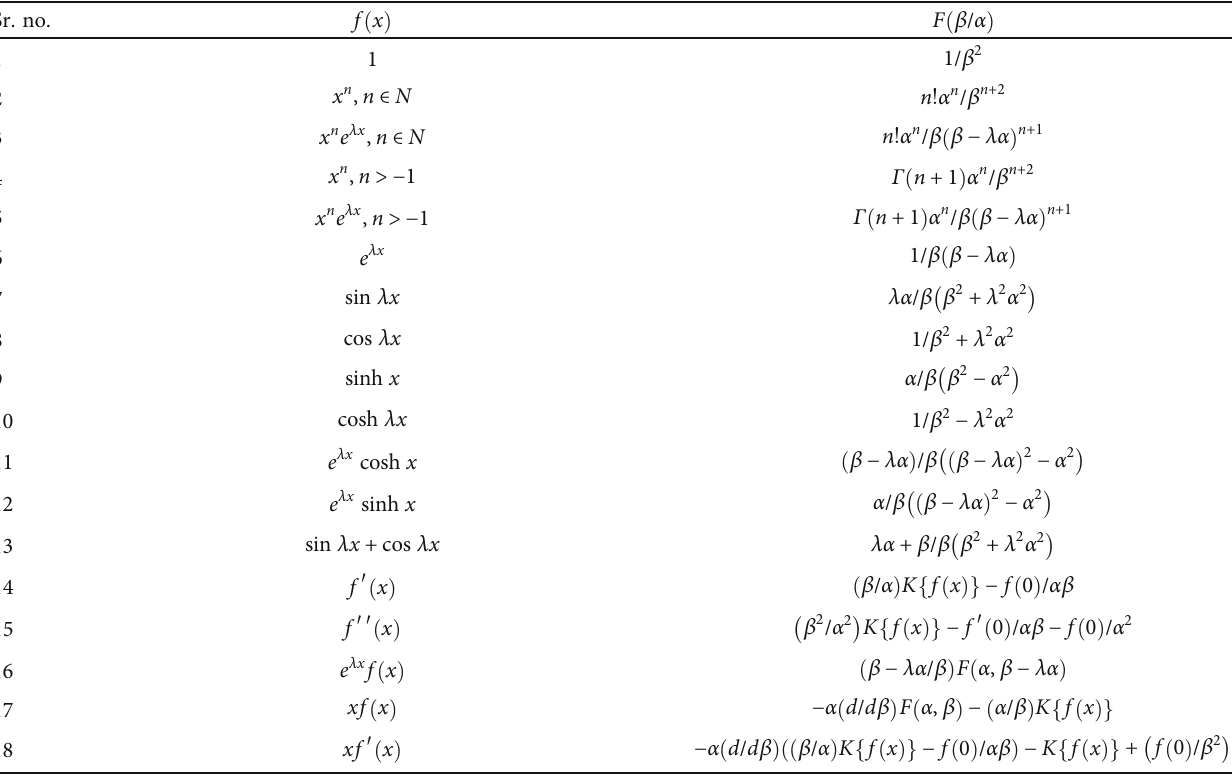
Table 2: KKAT of some important